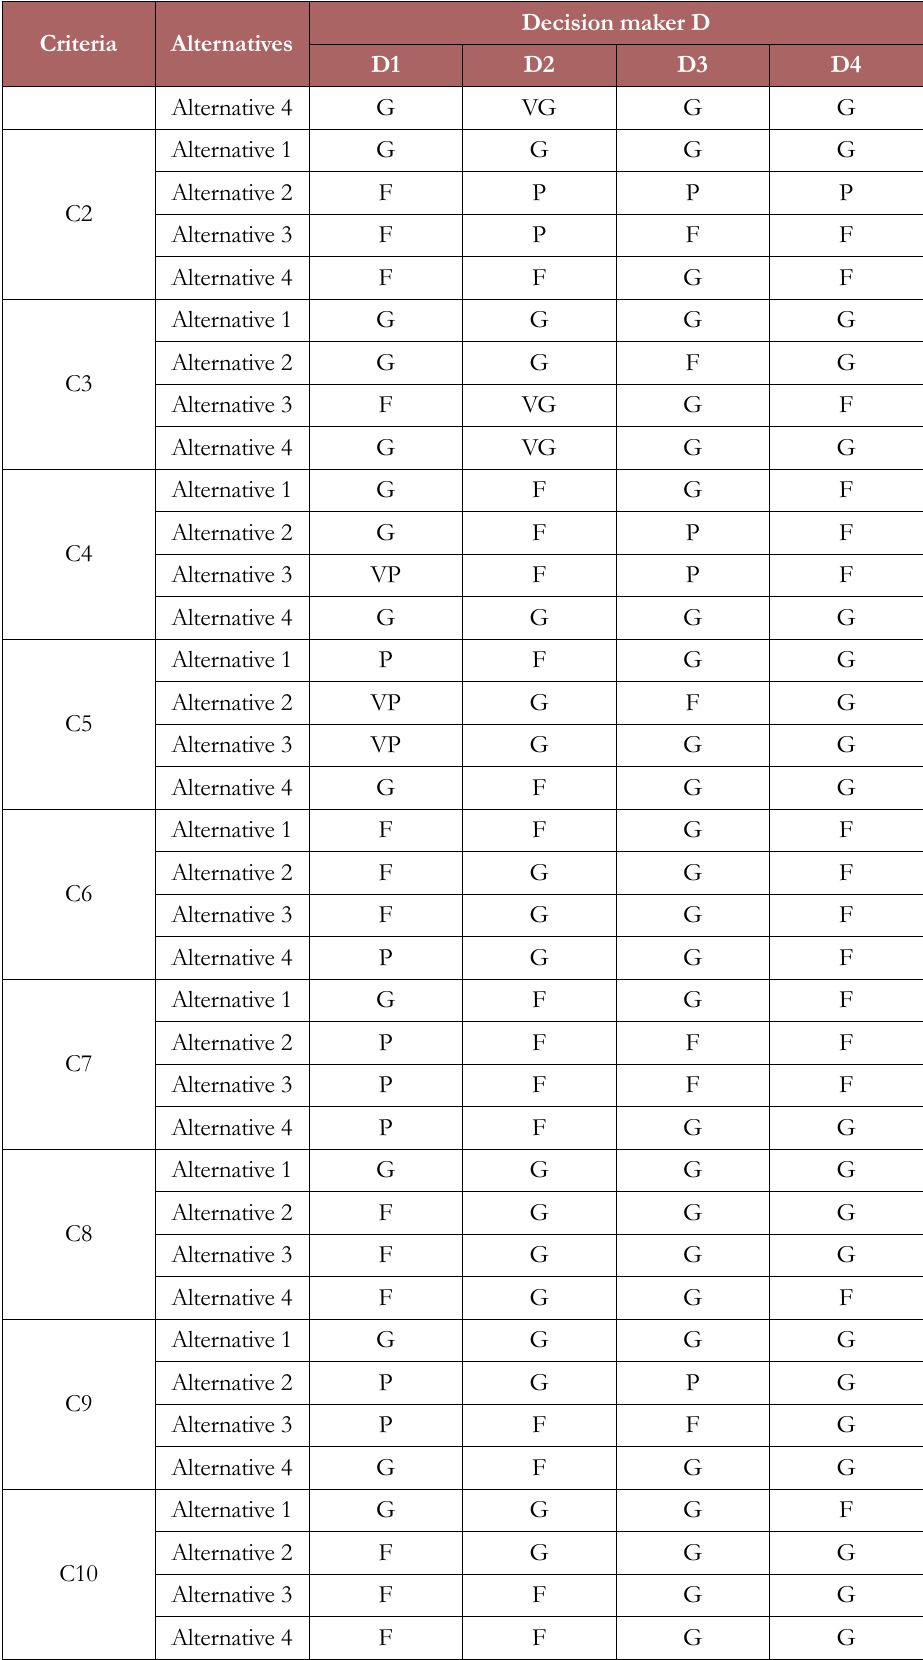
Table 7. Linguistic assessment for